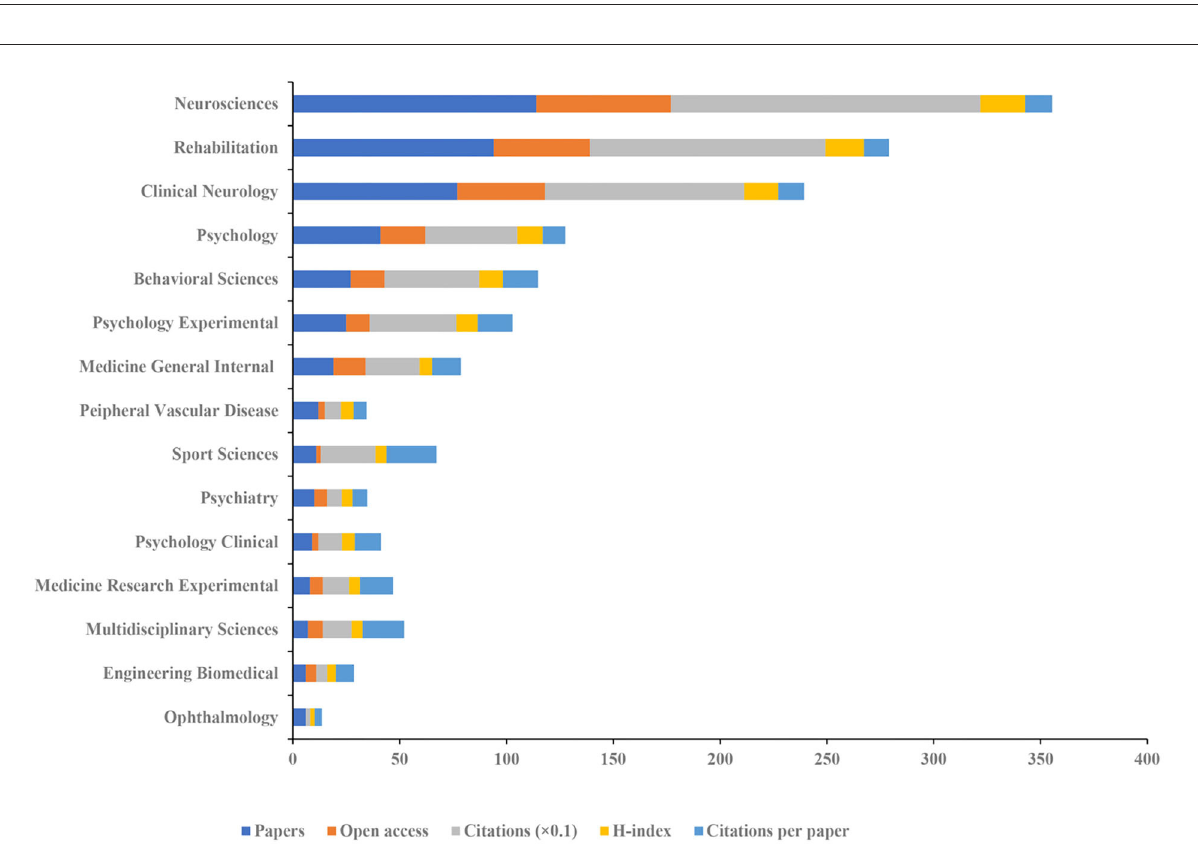
in the Cochrane Database of Systematic Reviews (19). Two of the top 10 papers were published in journals with IF ≥ 10 ( Brain and Nature Reviews Neurology